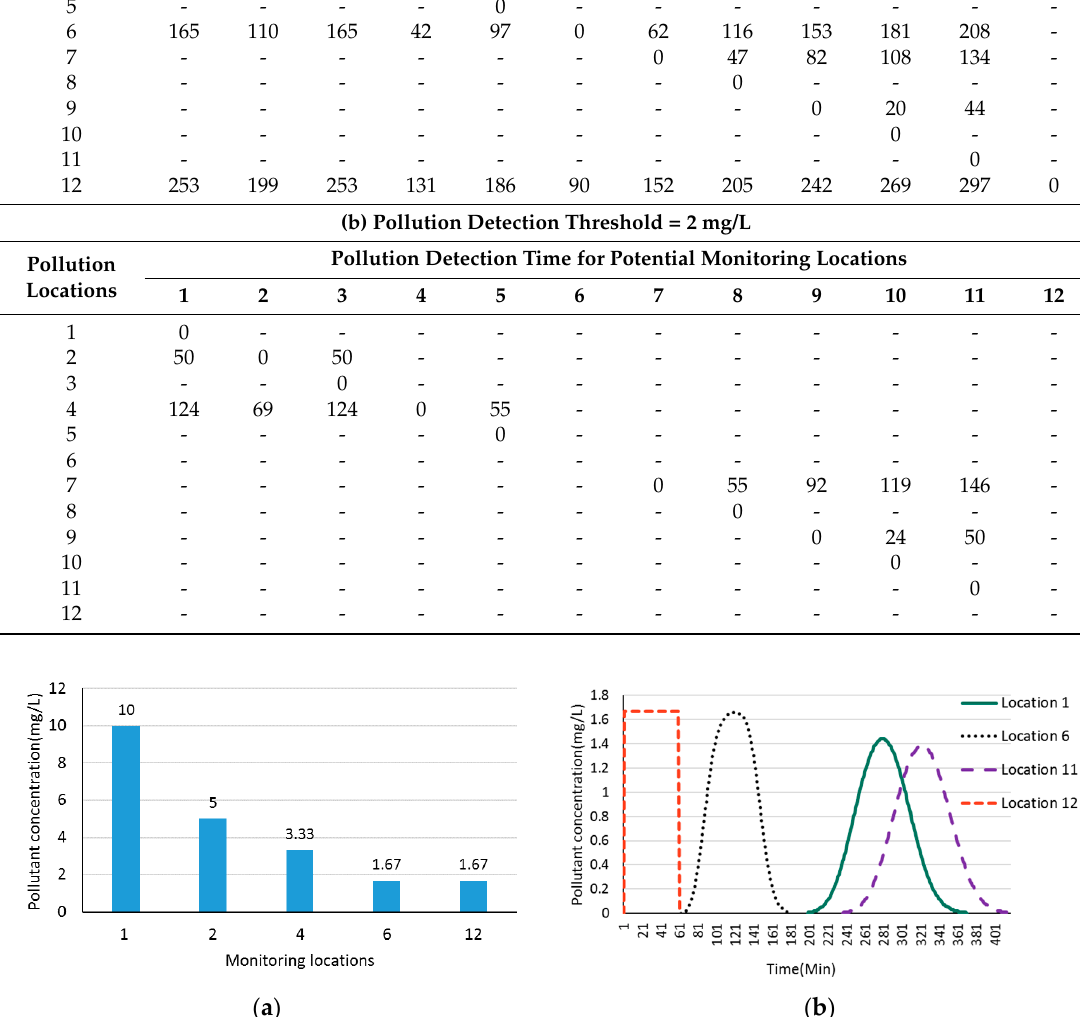
Figure 8. Dilution and changing process of pollutant concentration. ( a ) Dilution process of pollutant concentration when a pollution event occurs at location 1; ( b ) Changing process of pollutant concentration at location 12 when pollution event occurs at locations 1, 6, 11, and 12, respectively.